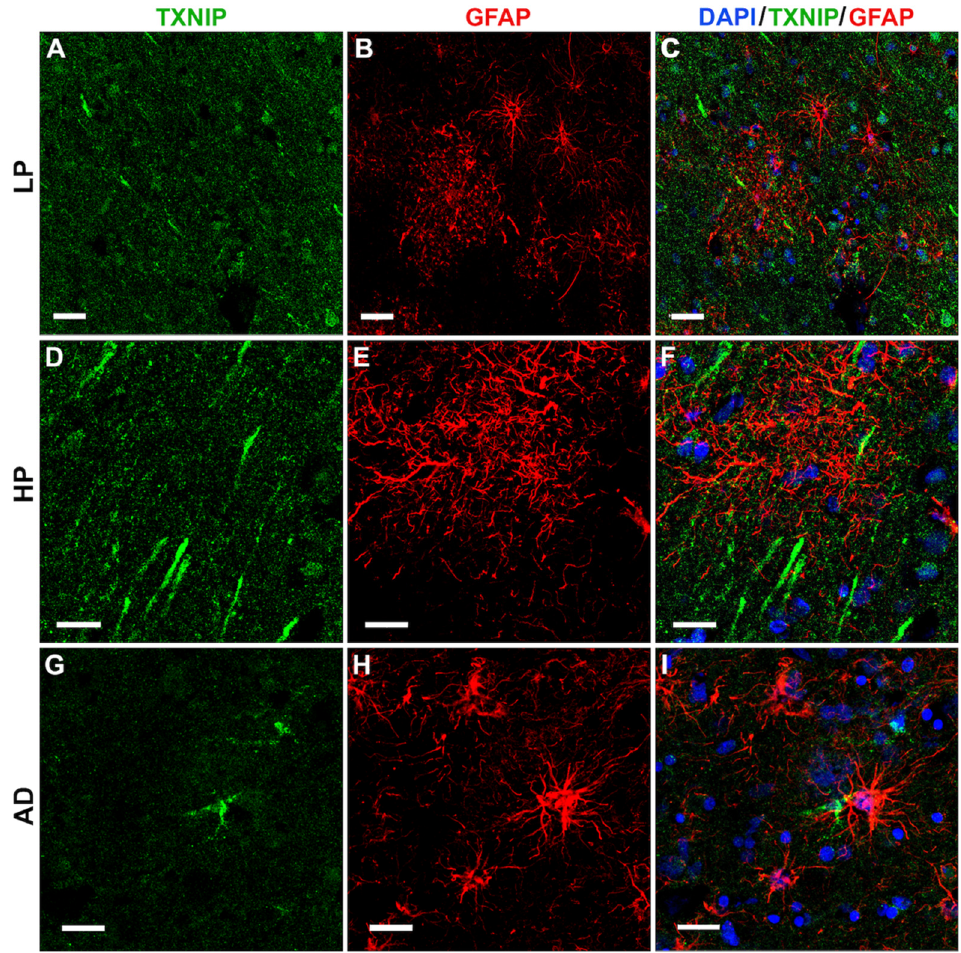
Figure 8. Confocal microscopy showing limited colocalization of TXNIP with astrocyte marker GFAP. All sections shown were from middle temporal gyrus. ( A – C ) LP case showing ( A ) TXNIP immunoreactivity (green), ( B ) GFAP immunoreactivity (red), and ( C ) merged image with DAPI staining (blue). ( D – F ) HP case showing ( D ) TXNIP immunoreactivity (green), ( E ) GFAP immunoreactivity (red), and ( F ) merged image with DAPI staining (blue). ( G – I ) AD case showing ( G ) TXNIP immunoreactivity (green), ( H ) GFAP immunoreactivity (red), and ( I ) merged image with DAPI staining (blue). Bars represents 30 μ m.